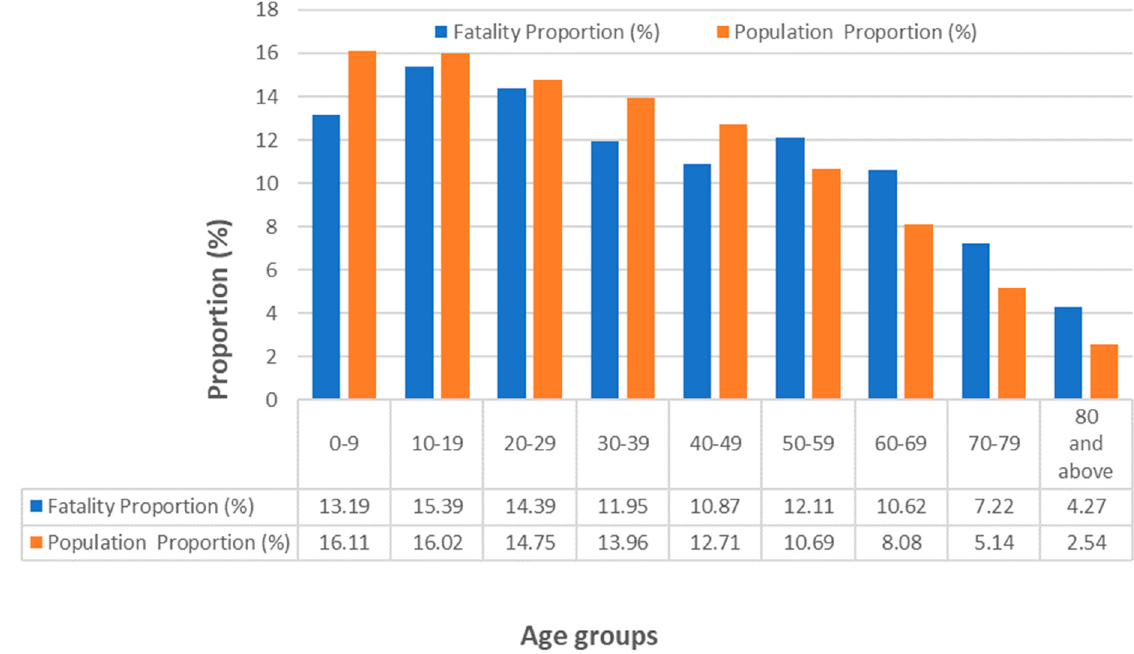
Figure 7. Distribution of flood fatalities by age group and average proportion of population in each age group in the contiguous US (1959–2019). Table 5. Flood fatalities by age group. The third column shows age-adjusted fatalities after multiply- ing by the proportion of population for each age